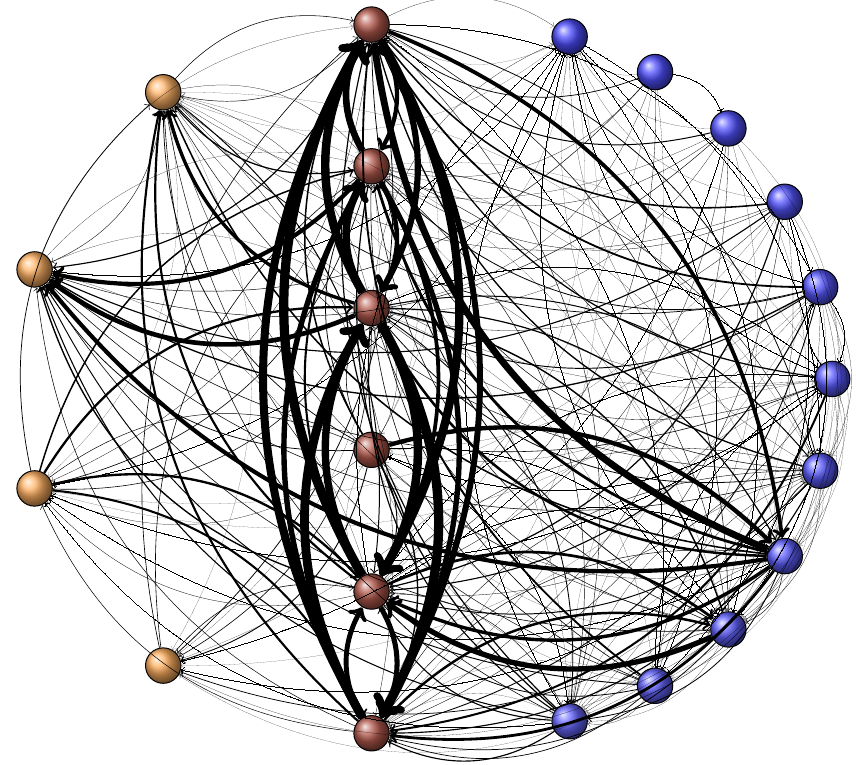
Figure 2. Network of French financial institutions for total exposures on a consolidated basis. The node color indicates the institution class (red for conglomerates, blue for pure insurers and yellow for pure banks); the edge width is proportional to exposure. The arrow starts from the owner of the exposure and ends at the counterpart with a left bent